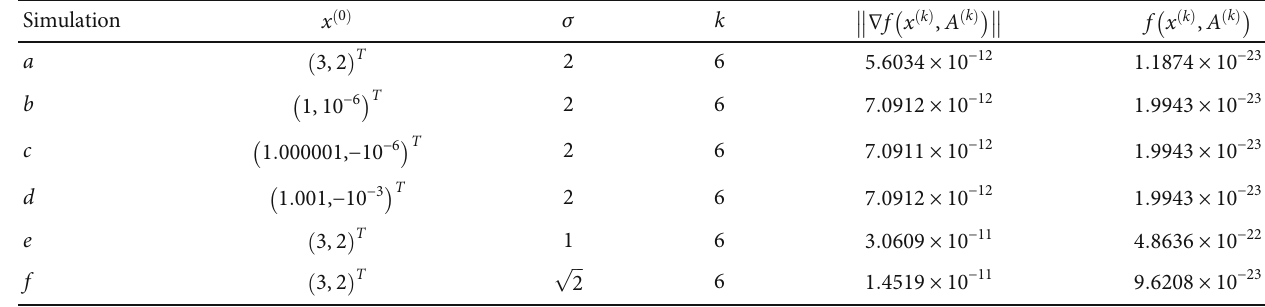
Table 1: Experiment 1: results of problem (9), given by Algorithm